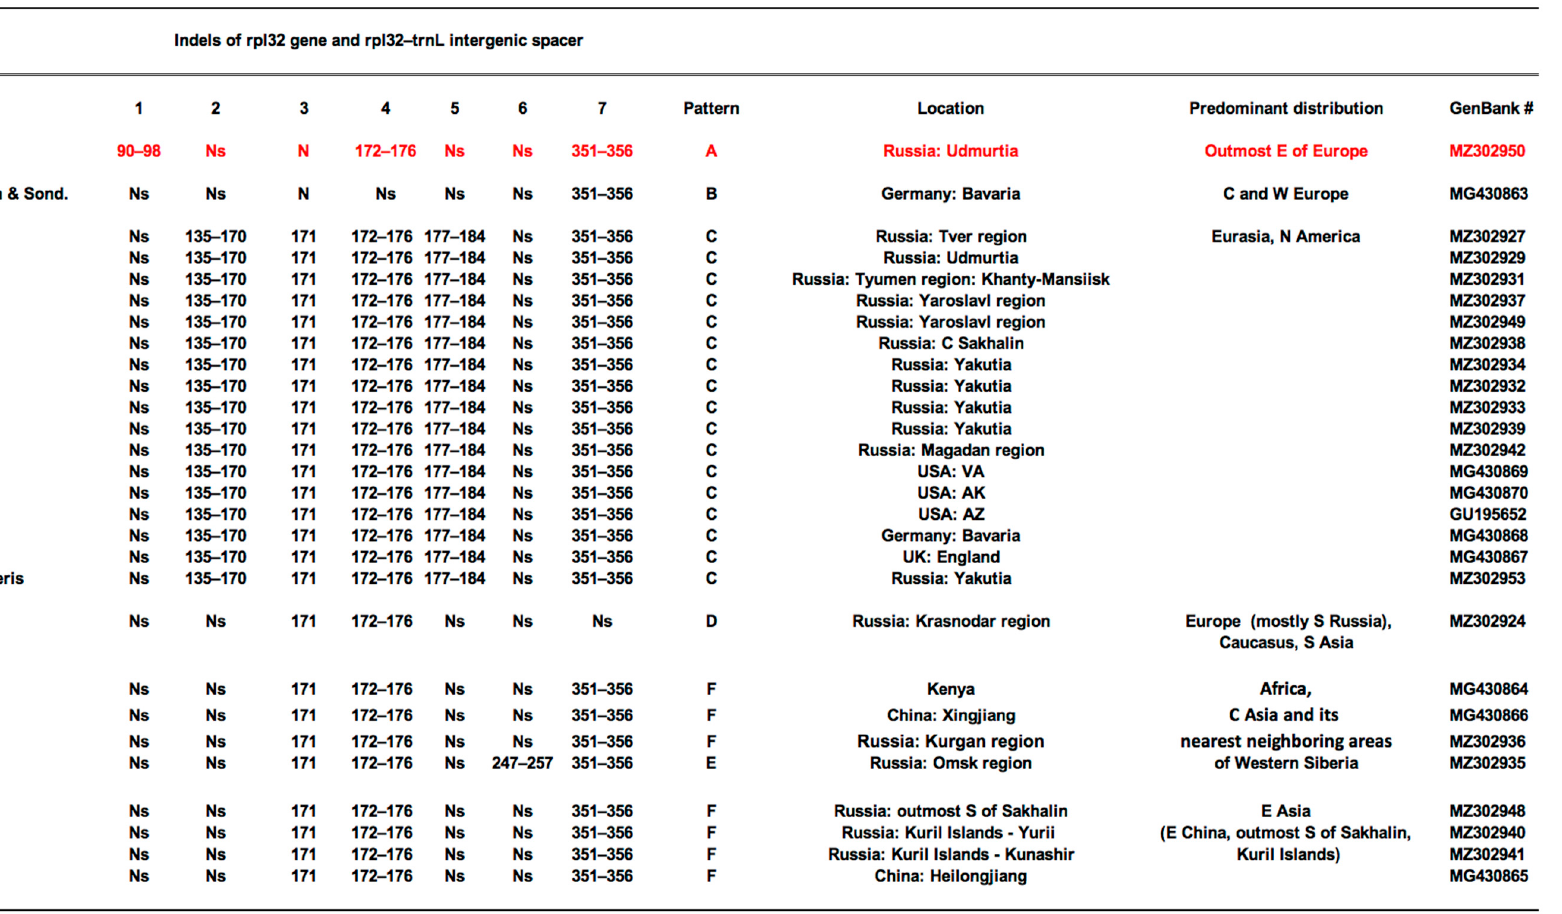
Figure 9. The summary of six patterns of variation of indels within plastid ( rpl32 gene– rpl32-trnL intergenic spacer) sequence data matrix of all analyzed species of Typha sect. Ebracteolatae were conducted with a special focus on T. lepechinii sp. nov. Numbers indicate missing entities, letter N means “aNy nucleotide”, letters A–F assigned for the different patterns of variation of the indels.